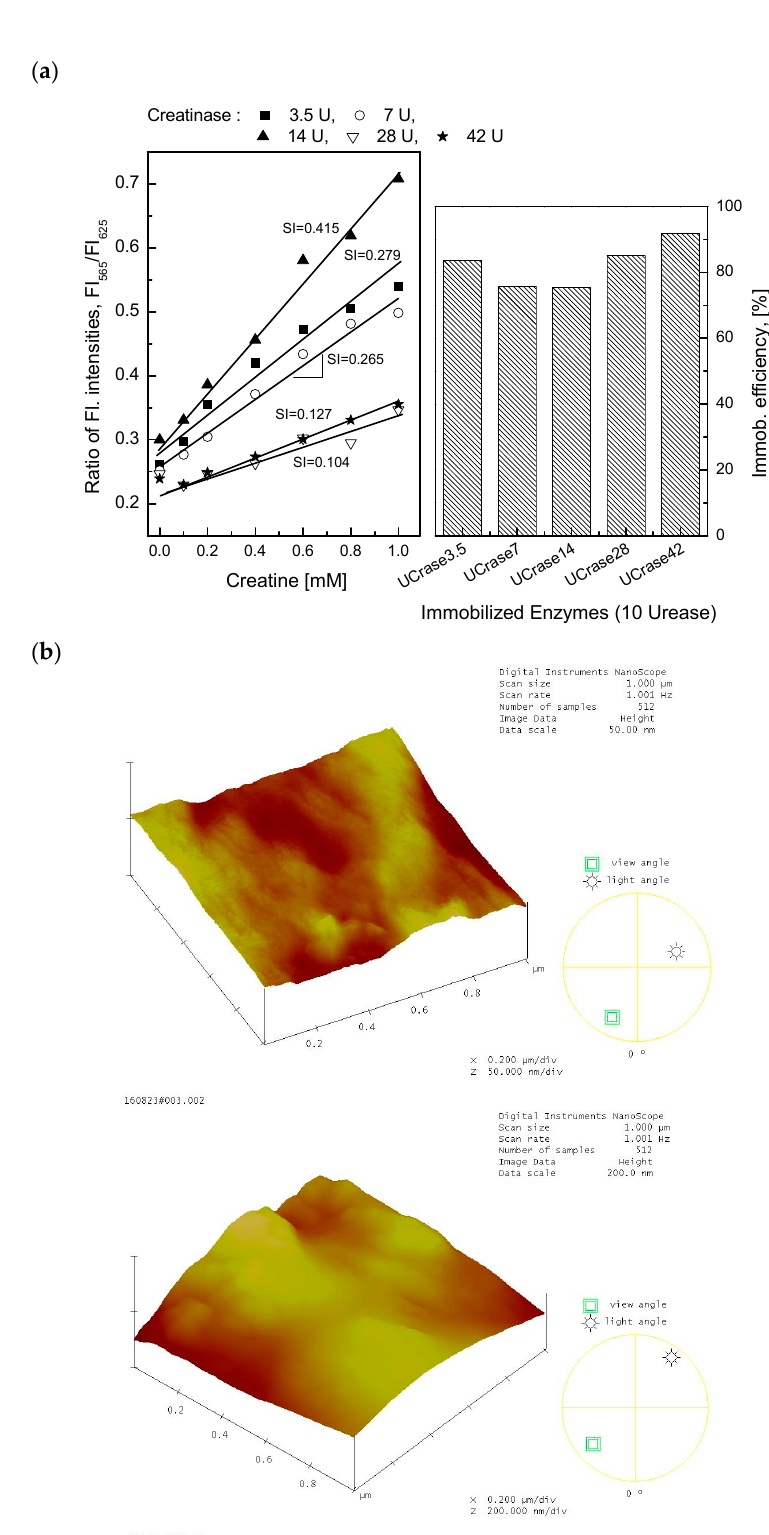
Figure 1. ( a ) The response of the creatine-sensing membrane immobilized with 3.5, 7, 14, 28, and 42 U creatinase and fixed amount (10 U) of urease in the presence of 0.1 to 1.0 mM creatine ( top ). SI presents slope value in the linear detection range of 0.1 to 1.0 mM. The immobilization efficiency for various amounts of creatinase and 10 U of urease ( top ); ( b ) AFM images of O17-EC membrane ( top ) and the second layer containing entrapped enzyme(s) ( below ).